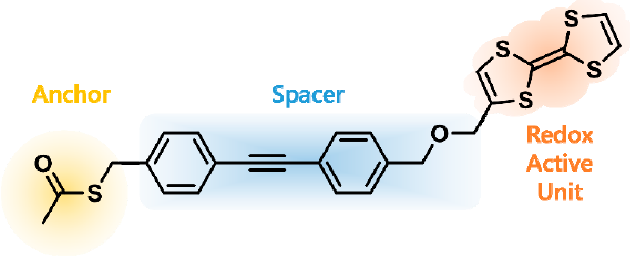
Figure 1. Structure of the ligand 1 used for AuNP modification.